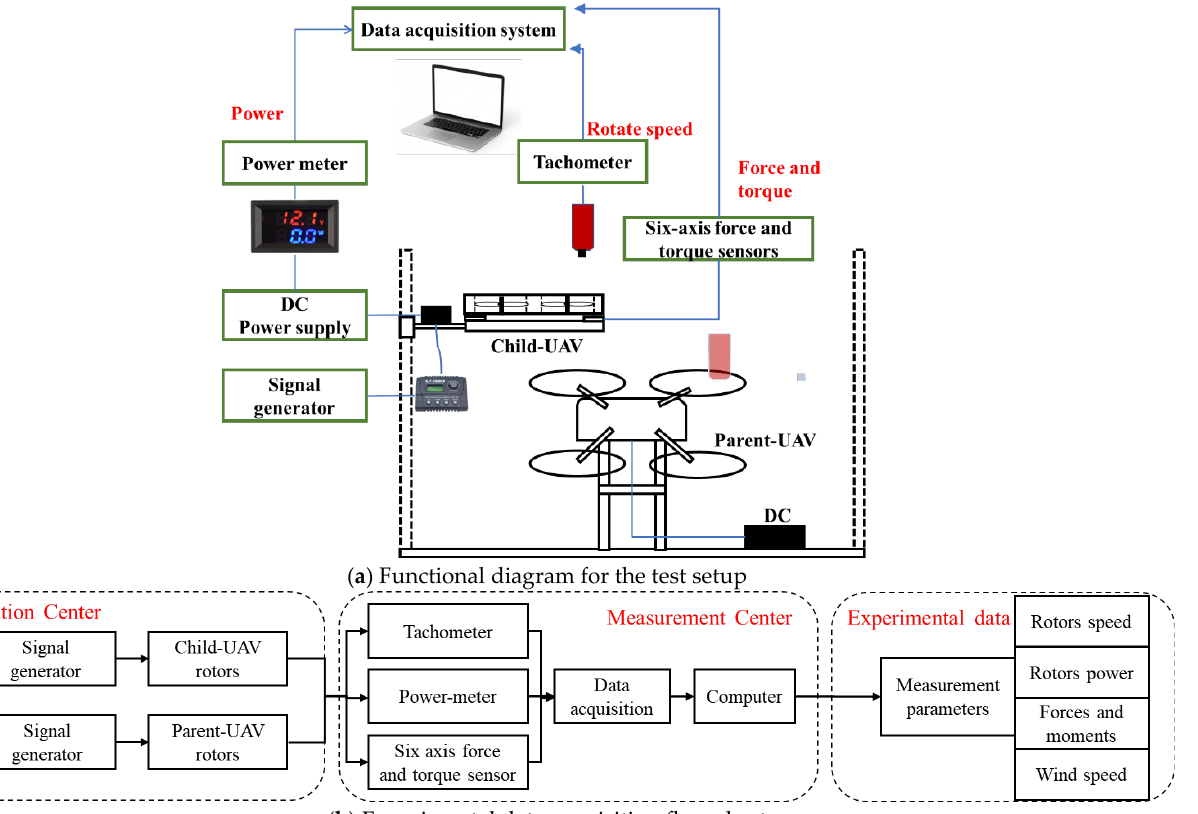
Figure 4. Experimental functional diagram.